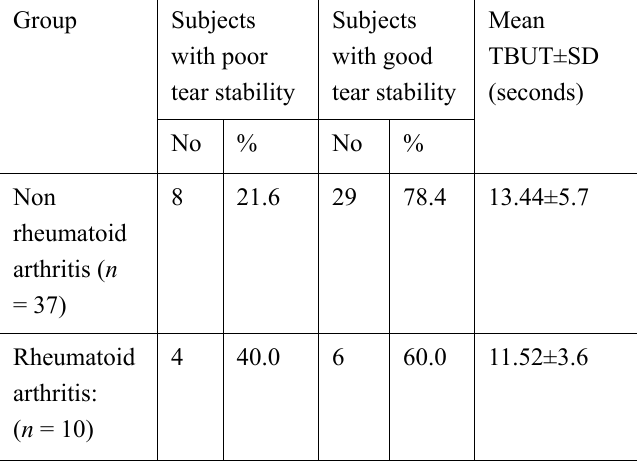
Table 6: Tear break-up time in different arthritic groups